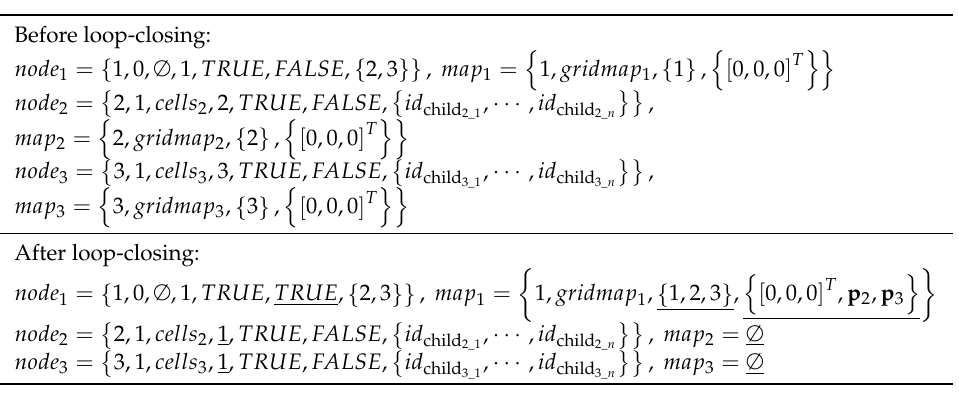
Table 2. An example of a frontier node and local map DB before/after